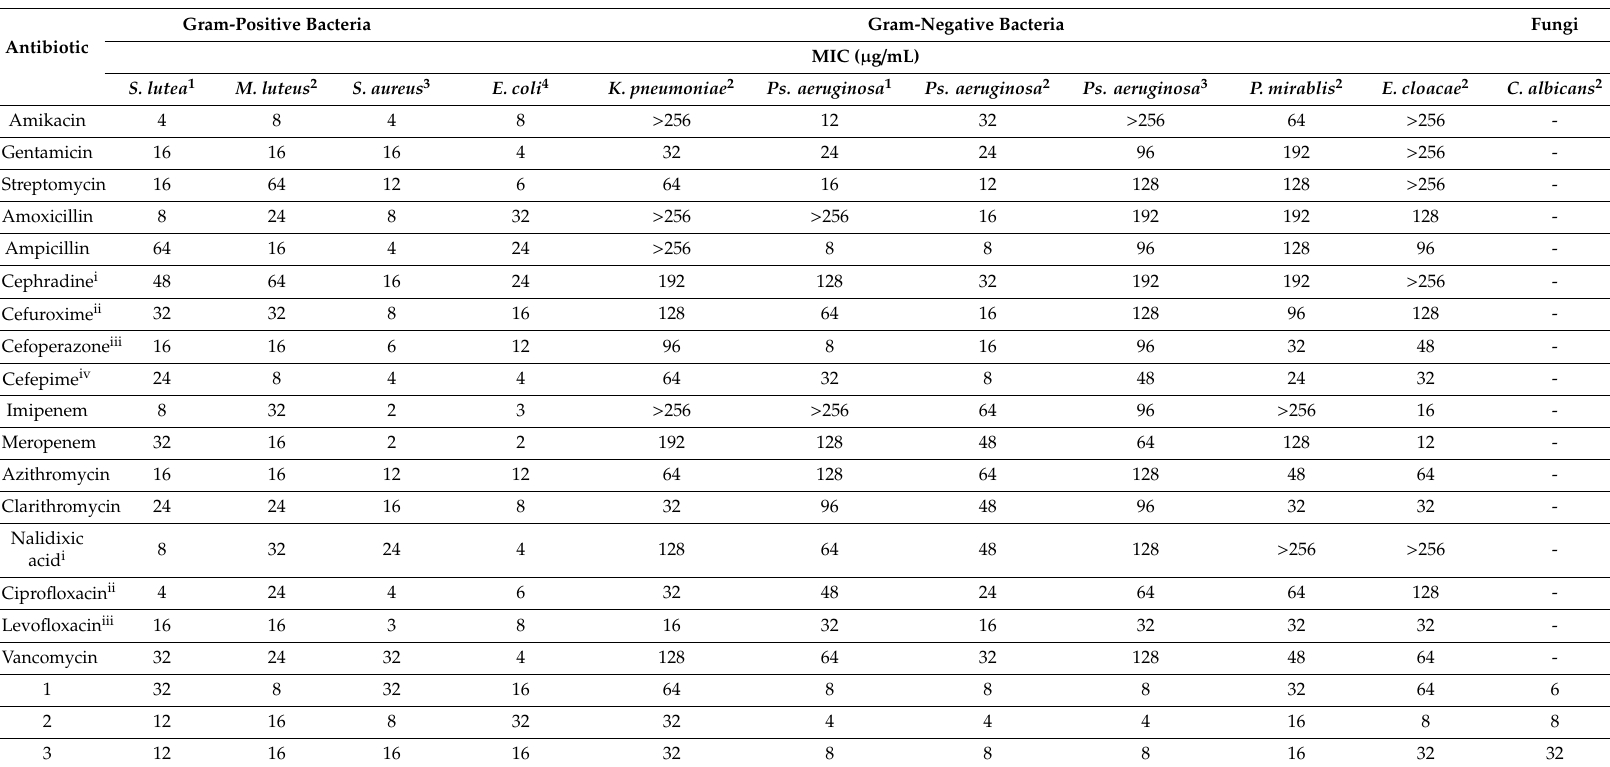
Table 2. Minimum inhibitory concentration (MIC) for complexes 1 – 3 compared with reference antibiotic drugs. (MIC ≥ 256 indicated no activity).